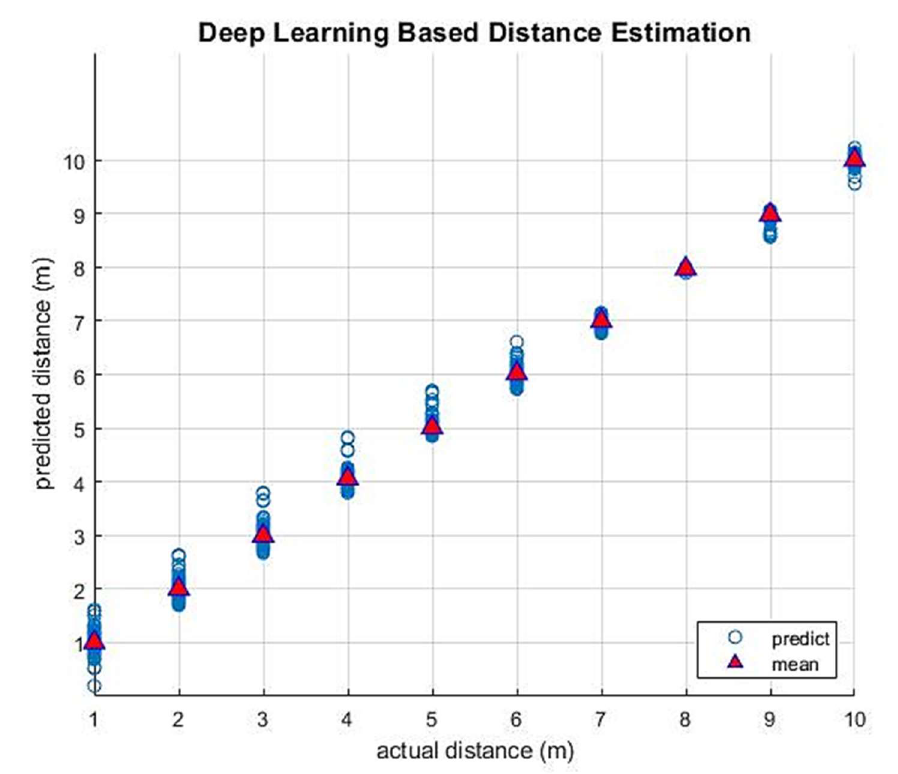
Figure 10. Distance estimation graph of proposed scheme.